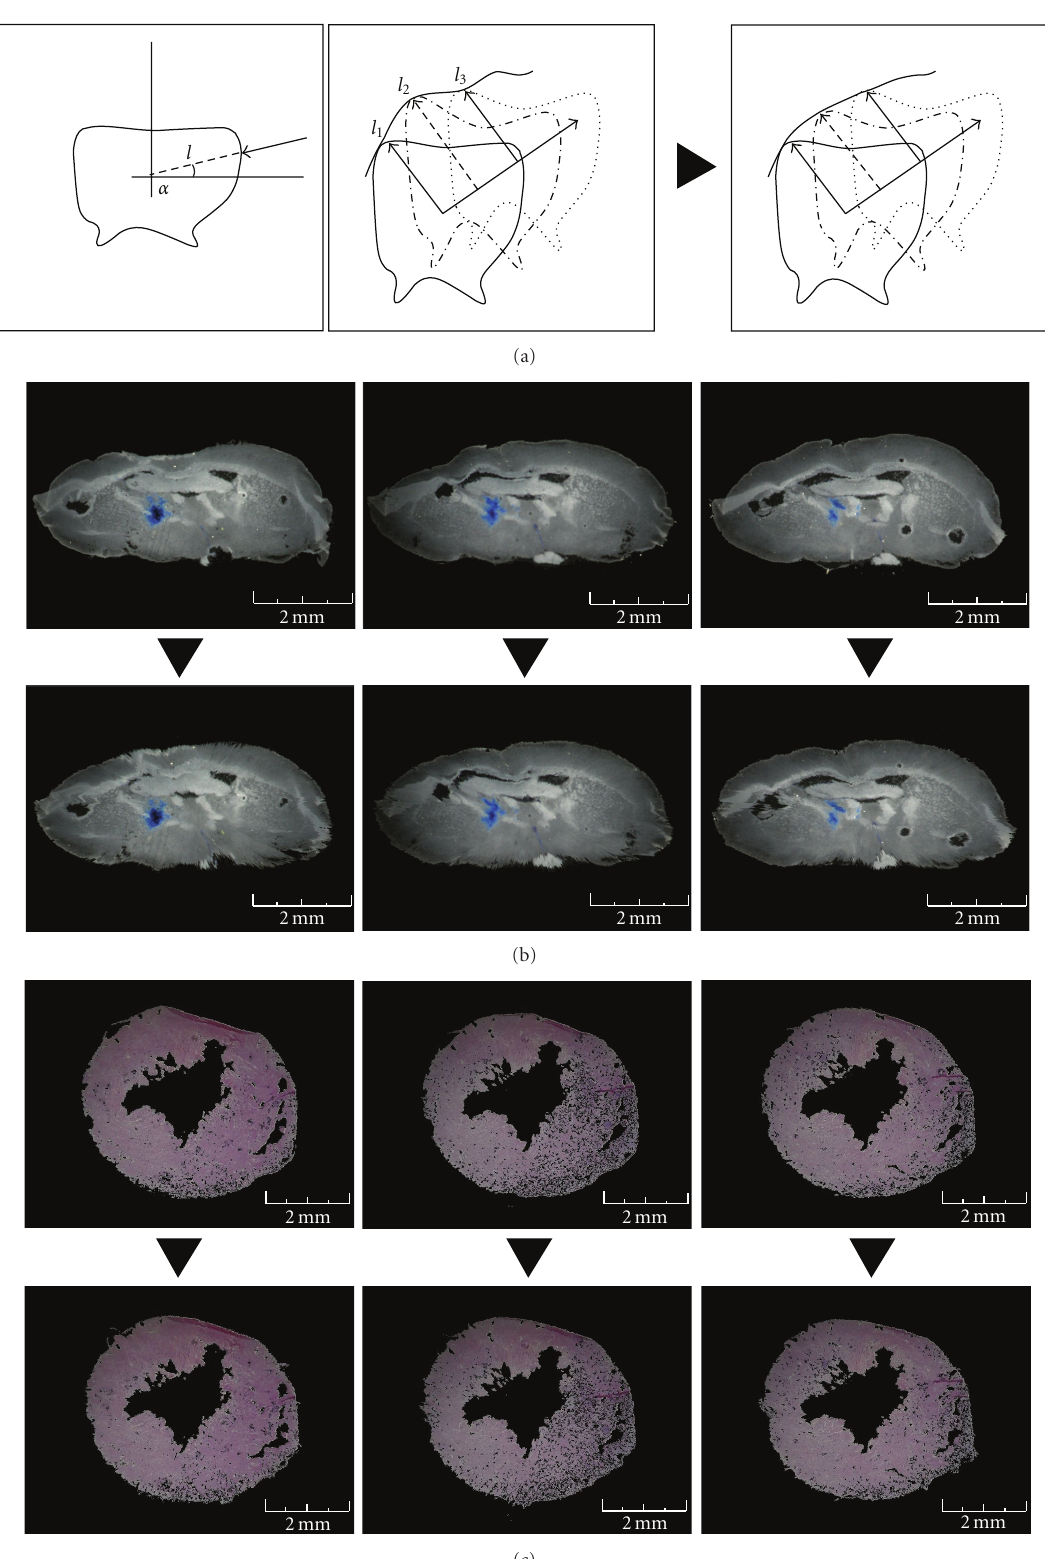
Figure 4: Reduction of the tissue deformation. (a) Outline of the tissue deformation routine (see routine 3). The discontinuity between the sections is diminished by the calculation of the medium of the contours. l n is the distance between the contour pixel and the centre of the bitmap of the n serial section for the angle α . With the distance of the contour pixels, the internal area pixels of the section are also adjusted by a proportional linear correction. (b) The images represent three original sequential sections of the brain. In the images below, the deformations have been reduced in order to carry out sequential images which are more homogenous. (c) The images represent three original sequential sections of the